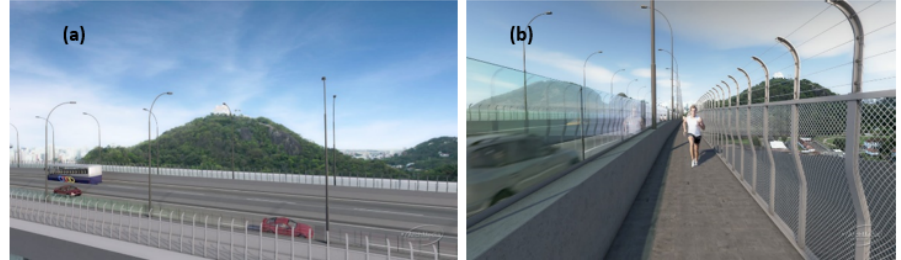
Figure 4. ( a ) Electronic model of the proposal overview; ( b ) technical solution